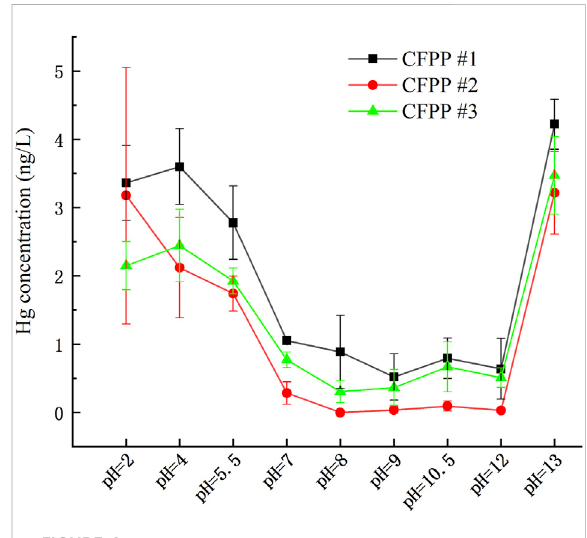
FIGURE 5 Hgreleasefractions fromcoal fl yashwith varyingsolid-liquid